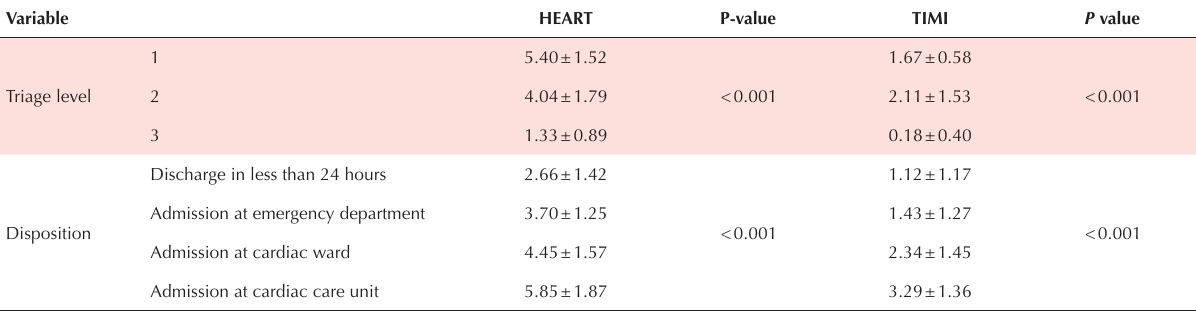
Table 4. Mean ± SD of HEART and TIMI score by triage level and disposition type